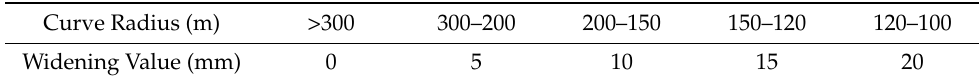
Table 7. Gage widening values in West German railways (mm).